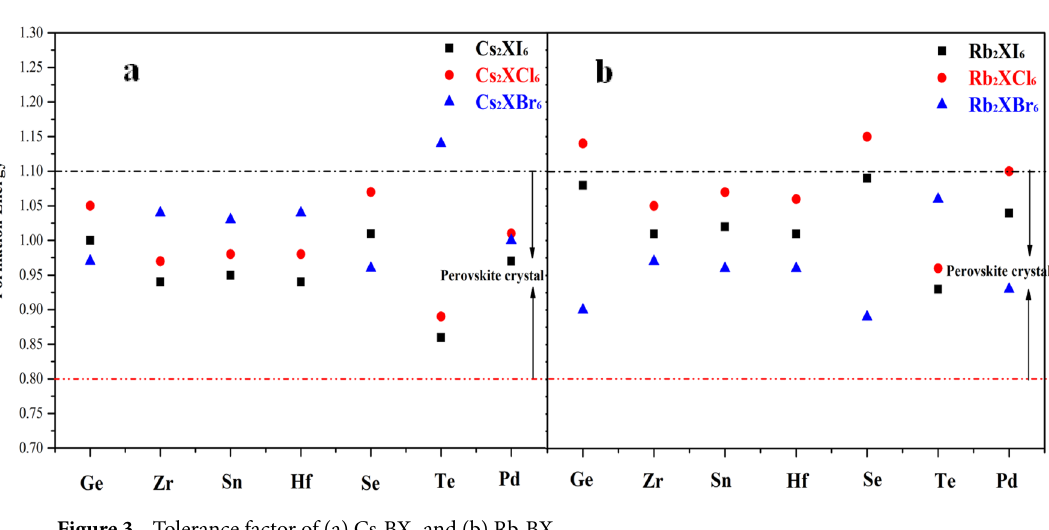
Figure 3. Tolerance factor of (a) Cs 2 BX 6 and (b) Rb 2 BX 6